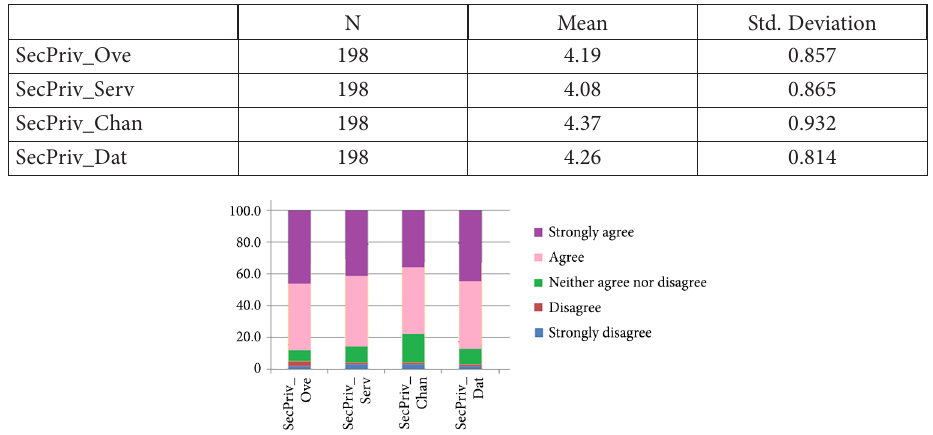
Figure 10. Respondents’ viewpoints regarding the variable security and privacy